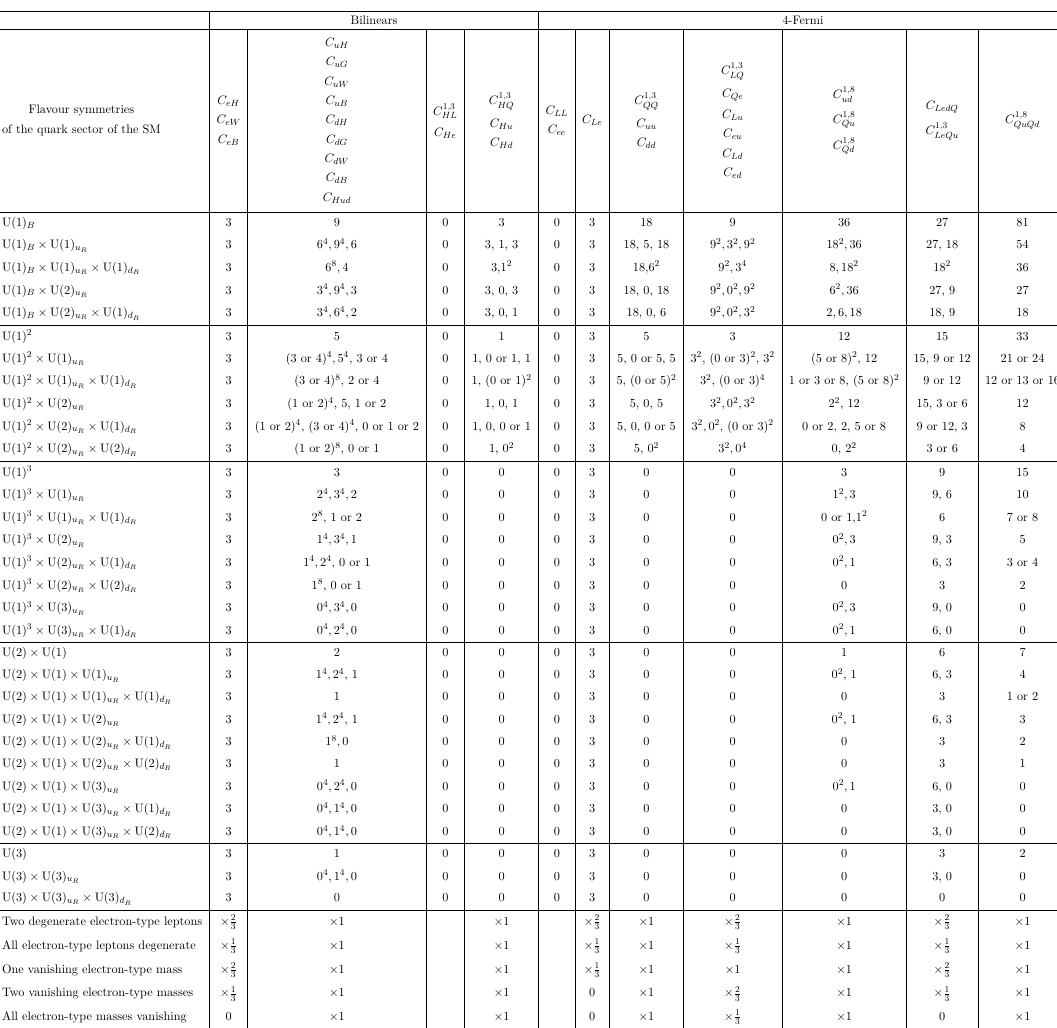
Table 6 . Numbers of new primary sources of CPV contained in each dimension-six SMEFT coefficient. When a single number appears, it applies to all operators at the top of the concerned column. When several numbers are needed, they appear as a list, where the integer power refers to the multiplicity of a given number. An entry “ i or j ” means that the answer depends on the details of the flavor charges. The last five rows indicate which multiplicative coefficient should be applied to all numbers of the same column for remarkable values of the electron-type lepton masses. The situation where m d = 0 , relevant for approximations in high-energy observables,